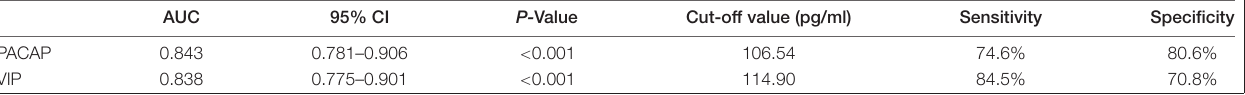
FIGURE 5 | ROC curve for serum PACAP and VIP levels comparing PD group and healthy control group. ROC curve, receiver operating characteristic curve; PD, Parkinson’ s disease; AUC, area under the curve; CI, confidence interval. AUC 95% CI P- Value Cut-off value (pg/ml) Sensitivity